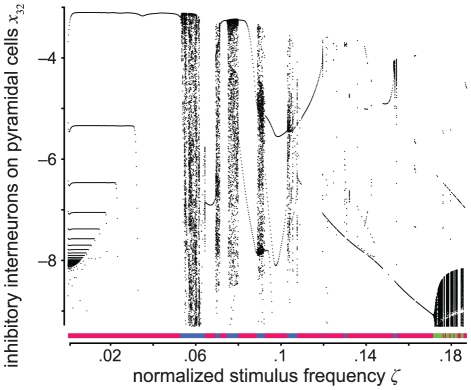
Bifurcation diagram for normalized stimulus amplitude ζ = 3.6301.The vertical axis is the normalized postsynaptic potential x
32 on pyramidal cells caused by inhibitory interneurons, that is, the coordinate of the intersection points (black dots) of trajectories with the Poincaré hyperplane after neglecting initial transients. The horizontal axis is the normalized stimulus frequency. The regimes are color-coded and indicated by the horizontal line. Periodic regimes (red) exist, for instance, for frequencies ranging from 0 to 5.34·10−2. In this range, the system appears to undergo a period-adding bifurcation cascade by decreasing the normalized stimulus frequency. Chaotic (blue) and quasi-periodic regimes (green) occur, for example, for frequencies ranging from 5.3·10−2 to 6.23·10−2 (scattered dots) and between 17.21·10−2 and 18.72·10−2. The classification can be also taken from Table 2.